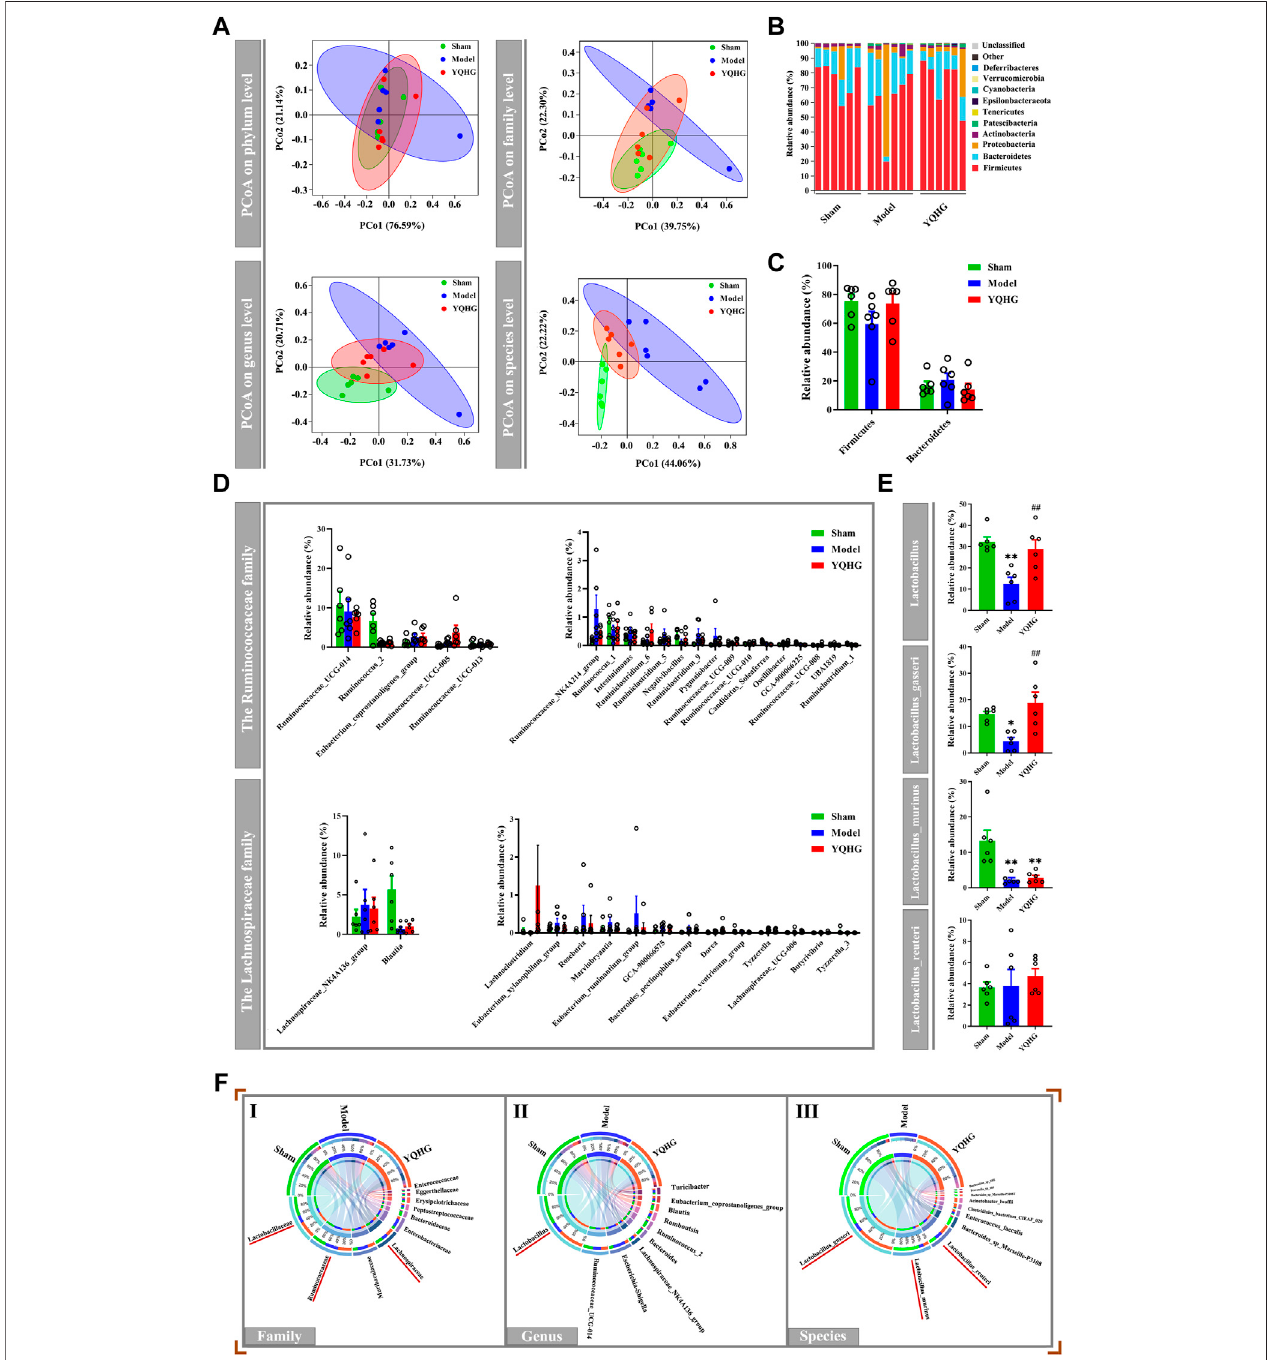
FIGURE 3 | YQHG treatment modulates the gut microbiota in 5/6 nephrectomized rats. (A) PCoA based on Bray-Curtis distance in bacterial communities on four levels (phylum, family, genus, species). (B) Relative abundance of gut microbiota on phylum level. (C) Relative abundance of Firmicutes and Bacteroidetes on phylum level. (D) Relative abundance of genera within the Ruminococcaceae family and Lachnospiraceae family. (E) Relative abundance of genera and species within the Lactobacillaceaefamily. (F) Circosdiagramofspecies-samplerelationshiponthreelevels(family,genus, species).Thesmallsemicircle(tophalfcircle)indicatesthe composition of the gut microbiota in each group, the color of the outer ribbon represents which group it comes from, the color of the inner ribbon represents the gut microbiota, and the length represents the relative abundance of gut microbiota in the corresponding group; the large semicircle (bottom half circle) indicates the distribution ratio of gut microbiota in different groups on the taxa level. The outer color band represents the gut microbiota, the inner color band represents different groups, and the length represents the distribution ratio of the group in a certain gut microbiota. All data are expressed as means ± SEM. For normally distributed data (Firmicutes, Bacteroidetes, genera within the Ruminococcaceae family and Lachnospiraceae family, Lactobacillus_gasseri, Lactobacillus_murinus, Lactobacillus_reuteri), one-way ANOVA followed by Tukey ’ s test was used. For non-normally distributed data (Lactobacillus), Kruskal-Wallis test followed by non- parametric Wilcoxon rank-sum test was used. * p < 0.05, ** p < 0.01 vs. the sham group; ## p < 0.01 vs. the model group.